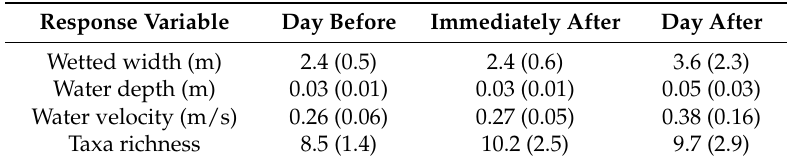
Table A1. Means (SD) of hydrologic and macroinvertebrate community response variables that did not differ among days (one day before, immediately after, one day after experimental disturbance) in riffles within three agricultural headwater streams of upper Alum Creek, 5–14 June 2015.